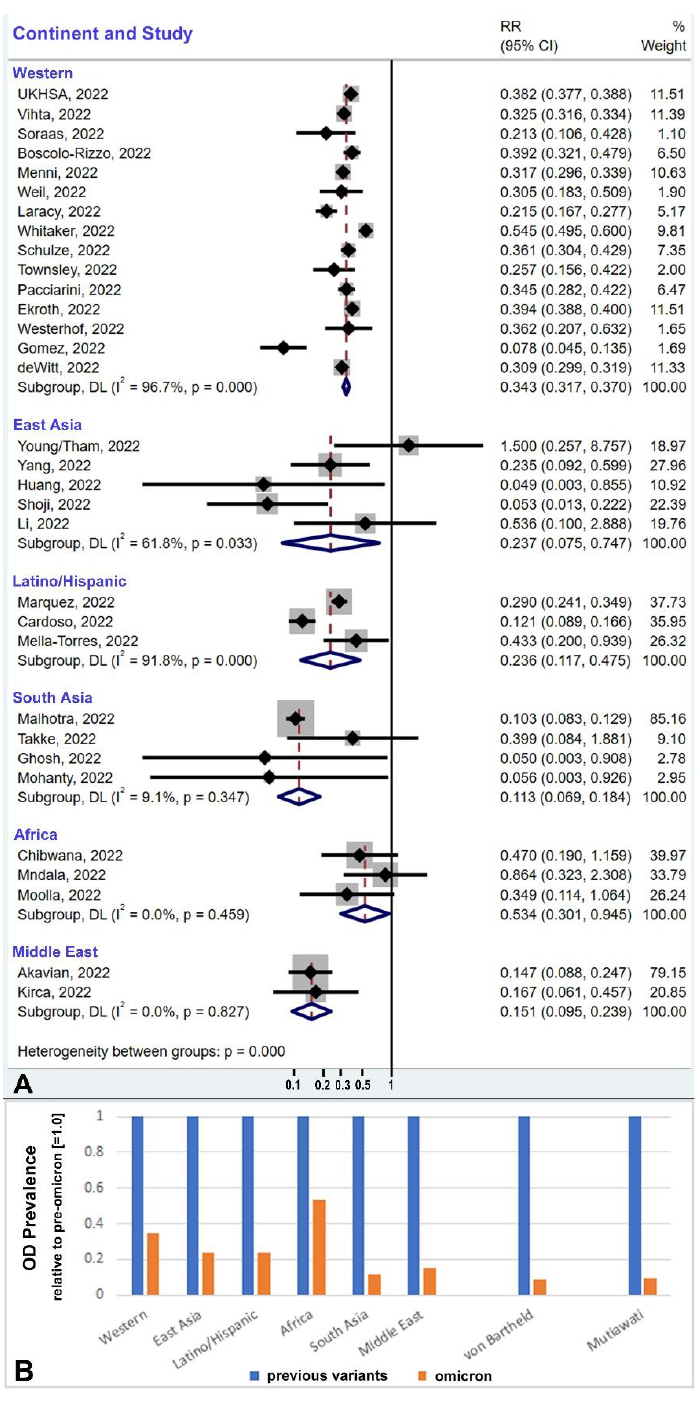
Figure 5. The prevalence of olfactory dysfunction (OD) due to omicron is reduced by 2-fold to 10-fold compared to the previous SARS-CoV-2 variants, regardless of ethnic population and region. ( A ) The reduction in OD due to omicron in direct comparison within similar populations and regions during the outbreak of the delta variant, predominantly (for specifics of the comparator variants, see Table 2). The size of the light-grey box is proportional to the study weight. ( B ) The bar graph summarizes the reduction in prevalence of OD for the direct comparisons from panel A (n=32), and two indirect comparisons with pooled estimates from previous meta-analyses, namely, von Bartheld et al., 2020 [99] and Mutiawati et al., 2021 [100]. The percentage of reduction ranges between 2-fold and 10-fold. CI, confidence interval; DL, DerSimonian – Laird method; I 2 , I-squared index, RR, risk ratio.